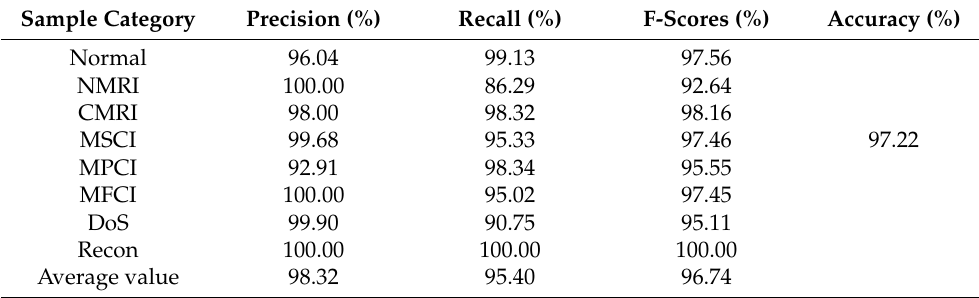
Table 6. Evaluation indicators of attack detection results.